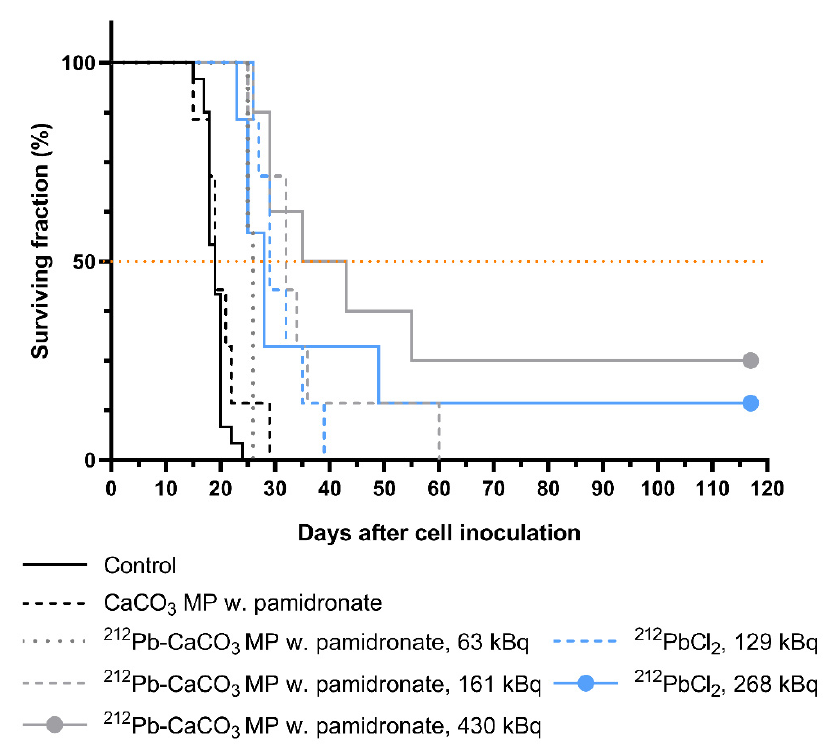
Figure 7. Kaplan–Meier curves of mice bearing ovarian cancer xenografts inoculated intraperitoneally on day 0 and treated with various i.p. treatments on day 1. Two mice were censored from the gray curve, and one mouse was censored from the blue curve due to long-term survival (beyond the study’s conclusion defined as 3 × the longest median survival time). Control group (pooled group from three separate experiments): n = 24; 430-kBq dose group: n = 8; all other experimental groups: n = 7.